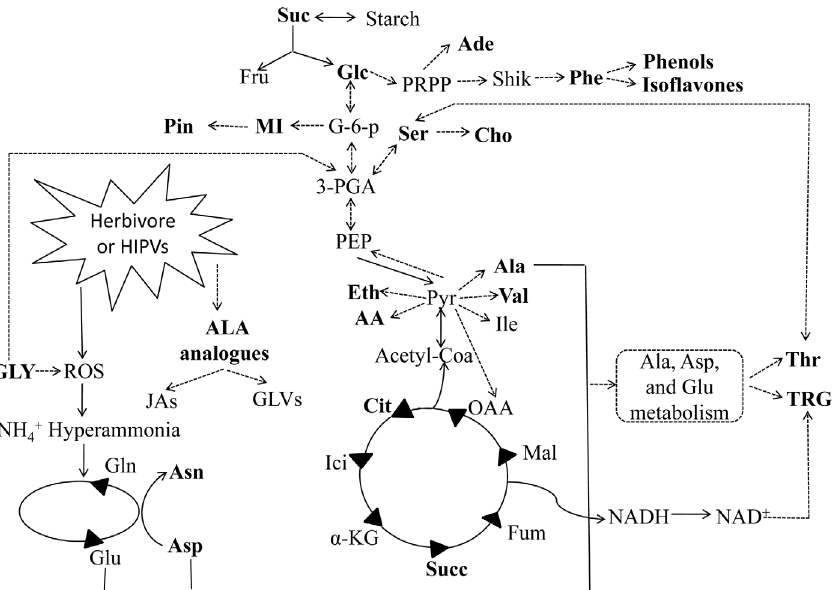
Figure 4. Herbivore and HIPVs exposure induced metabolic changes in leaves or roots. Metabolites identified were shown in bold letters. Dashed lines: multiple-step reactions; solid lines: one-step reactions. Abbreviations for metabolites: AA, acetic acid; Ade, adenine; Ala, alanine; ALA, a - linoleic acid analogues; Asn, asparagines; Asp, aspartic acid; Cho, choline; Cit, citrate; Eth, ethanol; F-6-P, fructose-6-phosphate; Fru, fructose; Fum, fumarate; Glc, glucose; Gln, glutamine; Glu, glutamate; GLVs, green leaf volatiles; GLY, glycolate; Ici, isocitrate; Ile, isoleucine; JAs, Jasmonates Mal, malate; MI, myo-Inositol; NAD + , nicotinamide adenine dinucleotide; NADH, nicotinamide adenine dinucleotide; OAA, oxaloacetate; PEP, phosphoenolpyruvate; 3-PGA, 3-phosphoglycerate; Phe, phenylalanine; Pin, pinitol; PRPP, 5-phosphoribosyl 1-pyrophosphate; Pyr, pyruvate; Ser, serine; Shik, shikimate; Suc, sucrose; Succ, succinate Thr, threonine; TRG, trigonelline; Val,valine; a -KG, alpha-ketoglutarate.